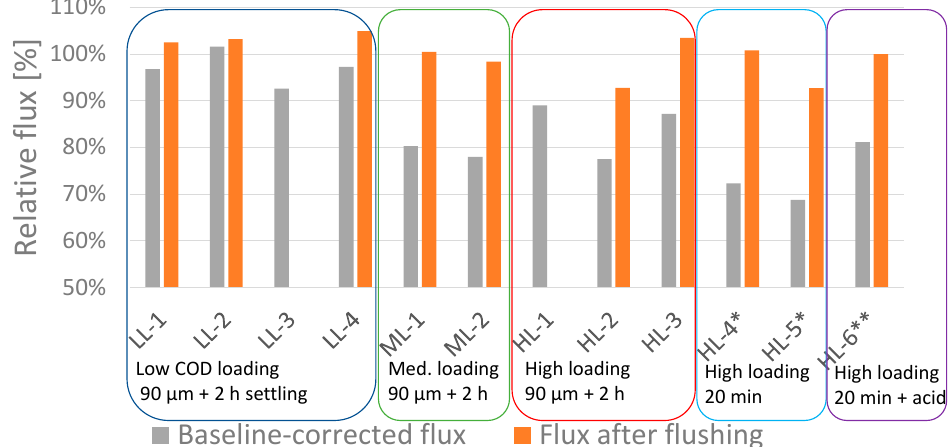
Figure 5. Relative baseline-corrected fluxes at the end of each FO experiment (grey bars) and relative values of pure-water flux measured after 15 min of high-rate flushing (orange bars). For two experiments (LL–3 and HL–1) high-rate flushing was not performed due to practical constraints.